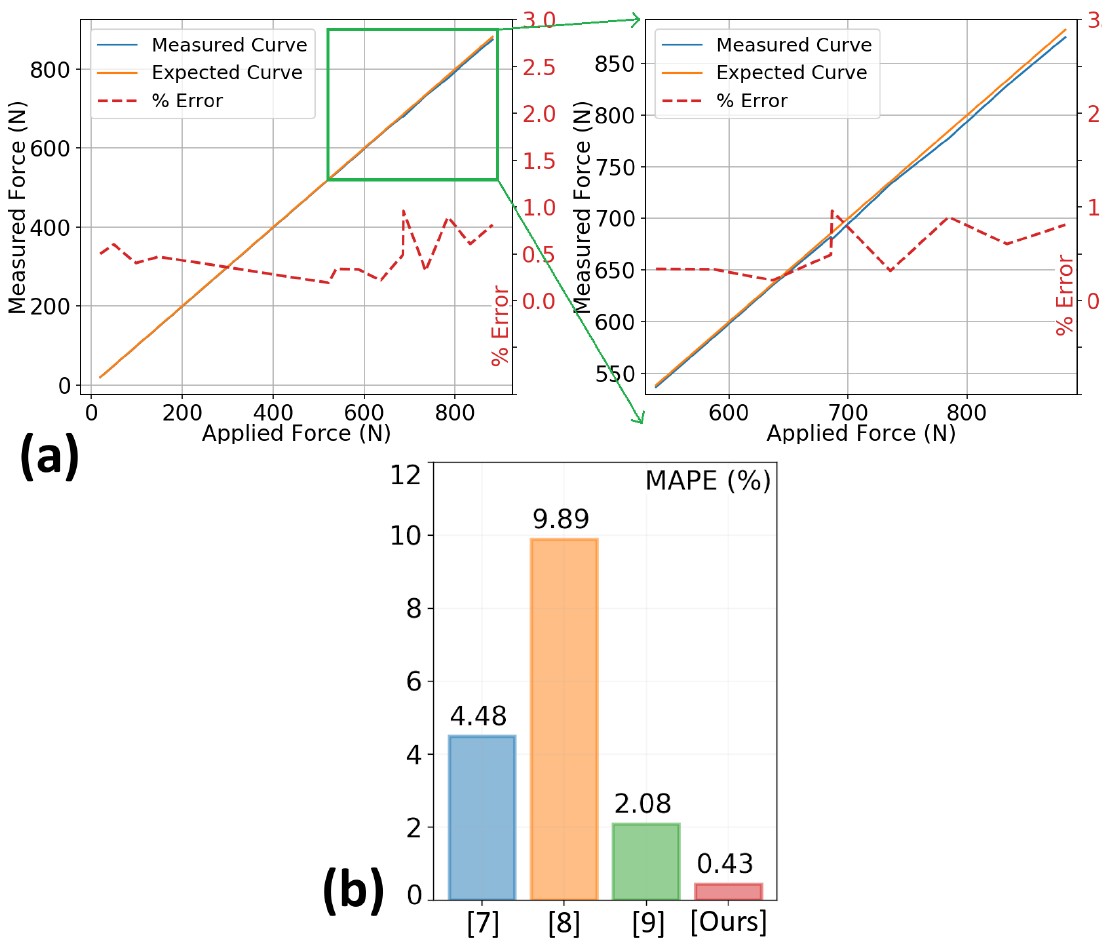
Figure 8. ( a ) Prototype Experimental Results ( b ) Accuracy Comparison: Wearable Weight Estimation